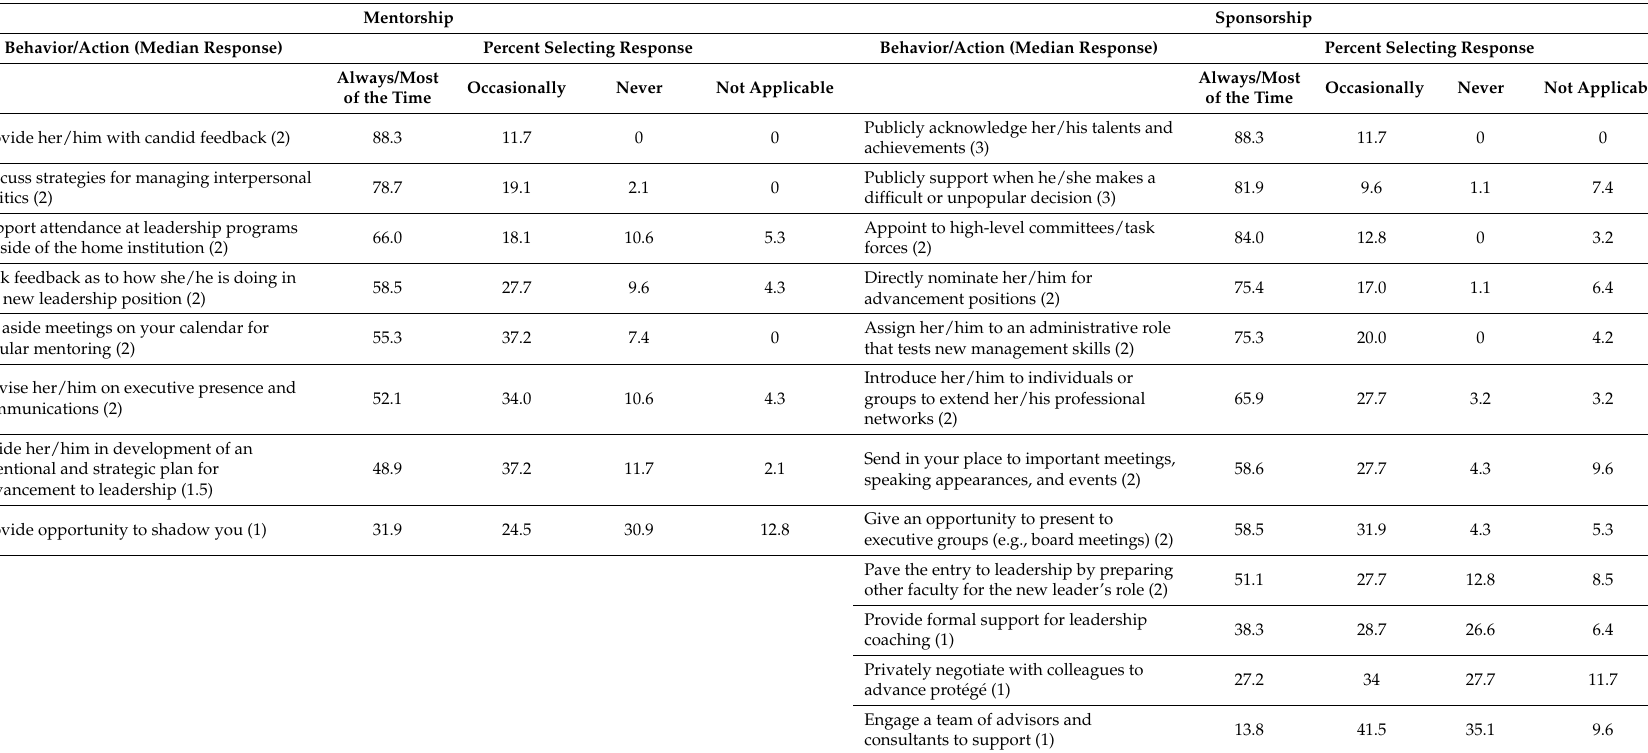
Table 3. Mentoring and sponsorship behaviors used by engineering education leaders to support emerging